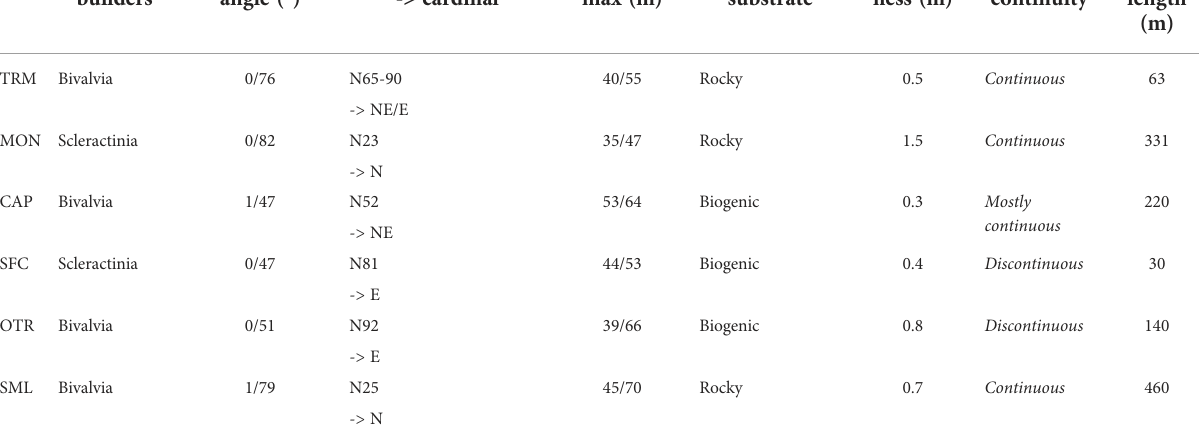
TABLE 1 Main features of the bioconstructions.